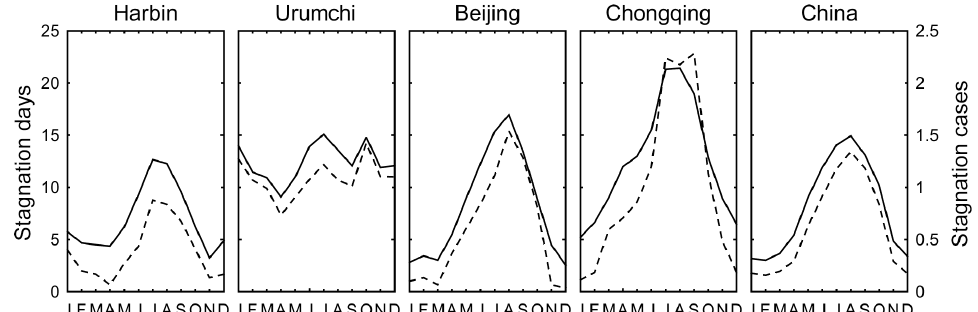
Figure 4. Seasonal cycles of monthly mean air stagnation days and cases for four stations (Harbin, Urumchi, Beijing, and Chongqing) and all of China. The solid line indicates stagnation days, and the dashed line indicates stagnation